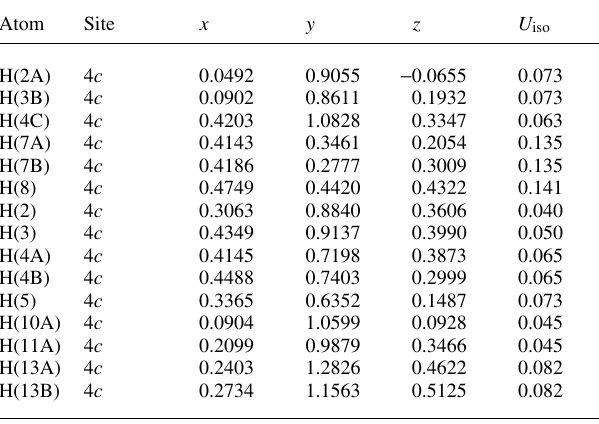
Table 2. Atomic coordinates and displacement parameters (in Å 2 )